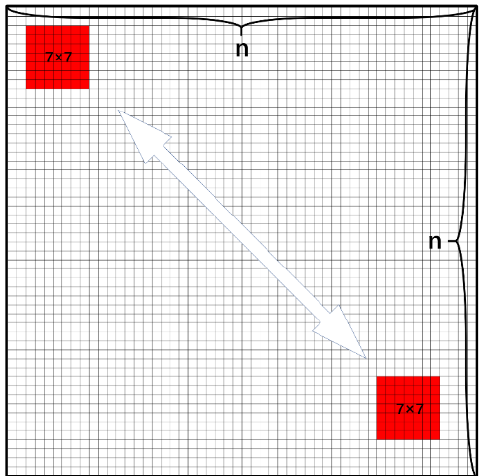
Figure 6. For feature maps of size n × n , there is an obvious lack of perceptual relationship between two 7 × 7 convolutions at longer distances.